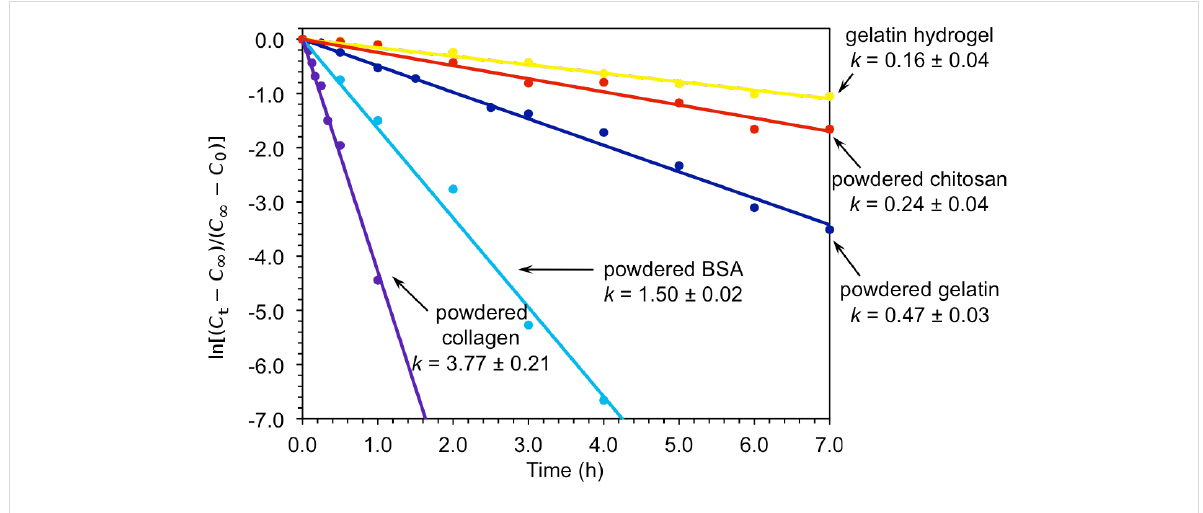
Figure 2: First-order kinetics plots for the model Henry reaction between 1a and 2a catalyzed by different systems. Apparent rate constants are in units of h − 1 . Each data point represents the average of two independent measurements. C ∞ = final concentration at infinite time; C t = concentration at given time t ; C 0 = initial concentration at t = zero time.